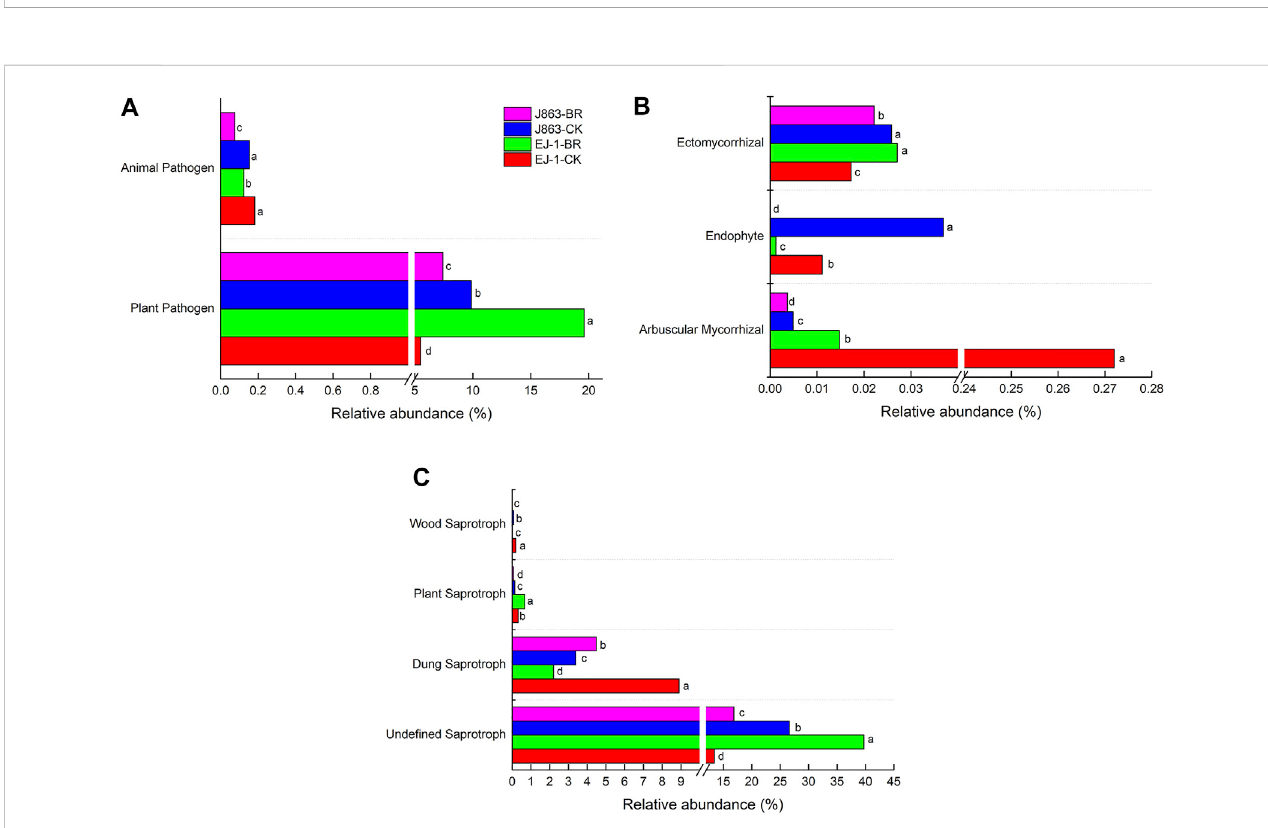
FIGURE 9 The relative abundance of mainly guilds assigned by FUNGuild for fungal communities. Different letters indicate signi fi cant difference between treatments detected by Student ’ s-T test ( P < 0.05). (A) pathotroph trophic mode (B) symbiotroph trophic mode (C) saprotroph trophic mode.